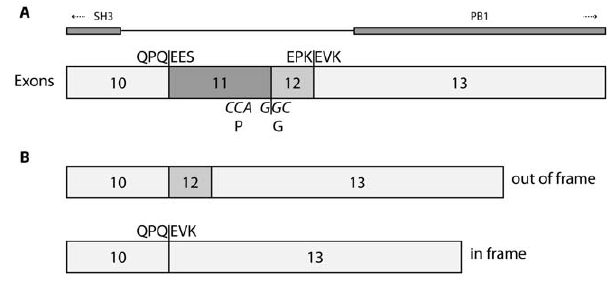
Figure 2. Schematic representation of the normal exon arrangement (A) and two main splice products in the patients (B). Italic letters represent the bp sequence at the exon 11/12 junction, the other capital letters represent the amino acid sequences at exonic junctions. The deletion of exons 11 and 12 does not affect a known functional domain (A, top), but may shorten the distance between the first SH3 domain (possibly binding to gp91-phox) and the PB1 domain (binding to p40-phox).